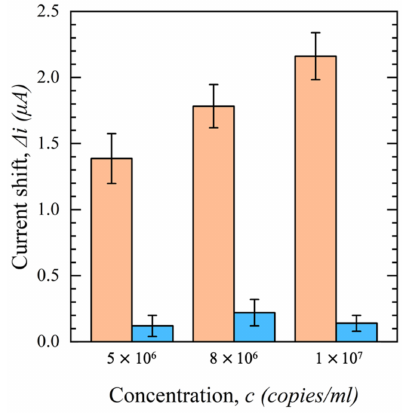
Figure 16. Current shift ( ∆ i ) of functionalized sensors with S1-Ab (orange) and mouse IgG (blue) as a function of PV concentration in DMEM + 10% FBS ( n =